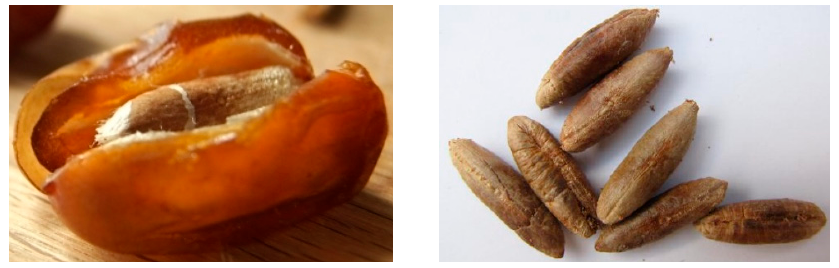
Figure 2. Development of date fruit over time [16].